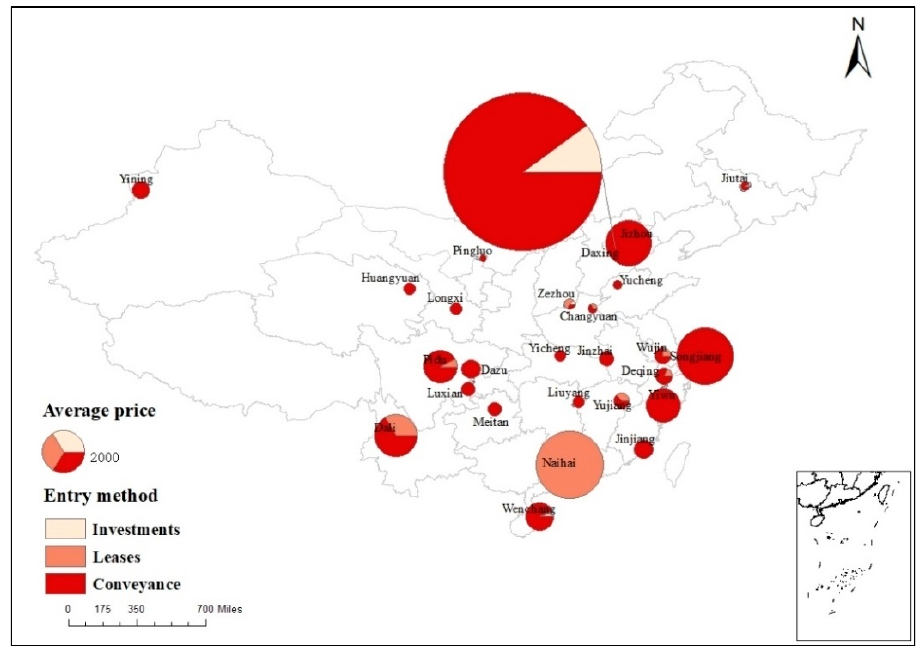
Figure 6. Entry methods and average price in 26 pilot areas.